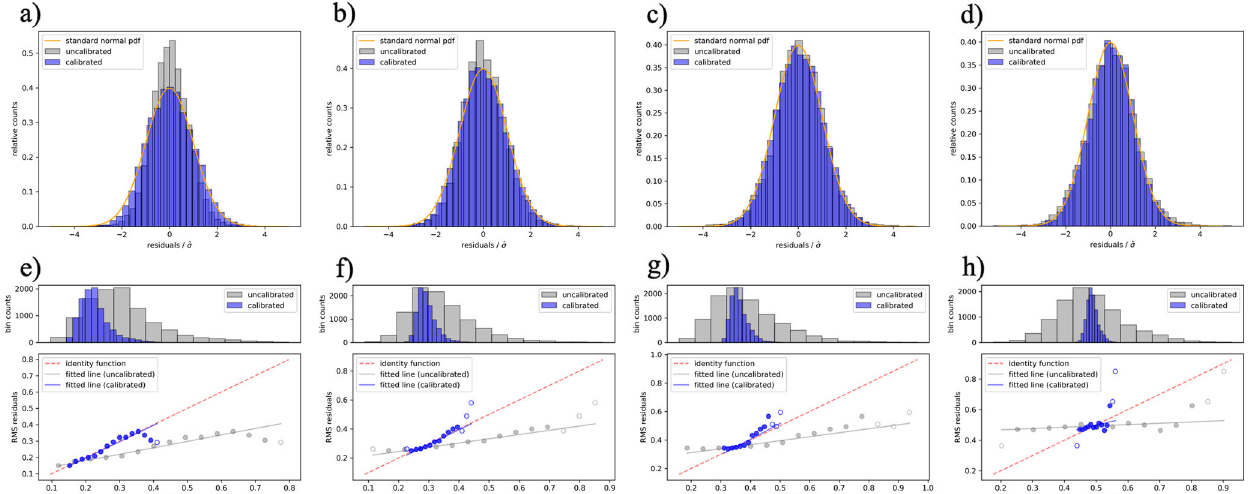
Fig. 4 Calibrated and uncalibrated r-statistic and RvE plots for random forest using synthetic data with noise added. Distributions of r-statistic values and RMS residual vs. ^ σ plots for random forest, using the synthetic dataset with varying amounts of noise added. Gaussian noise with mean zero and standard deviation equal to 0.1 (panels a and e ), 0.2 (panels b and f ), 0.3 (panels c and g ), and 0.5 (panels d and h ) times the standard deviation of the training set with no noise added. Both uncalibrated and calibrated ^ σ are shown. Markers which are not fi lled in represent bins with fewer than 30 points. Statistics for each plot are summarized in Table